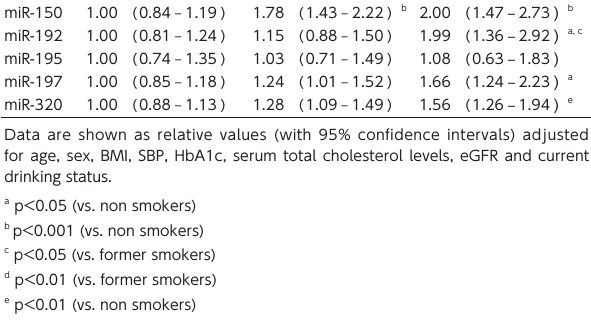
Table 3. Multivariate-adjusted odds ratios and 95% confidence intervals for elevated serum miRNA according to smoking status